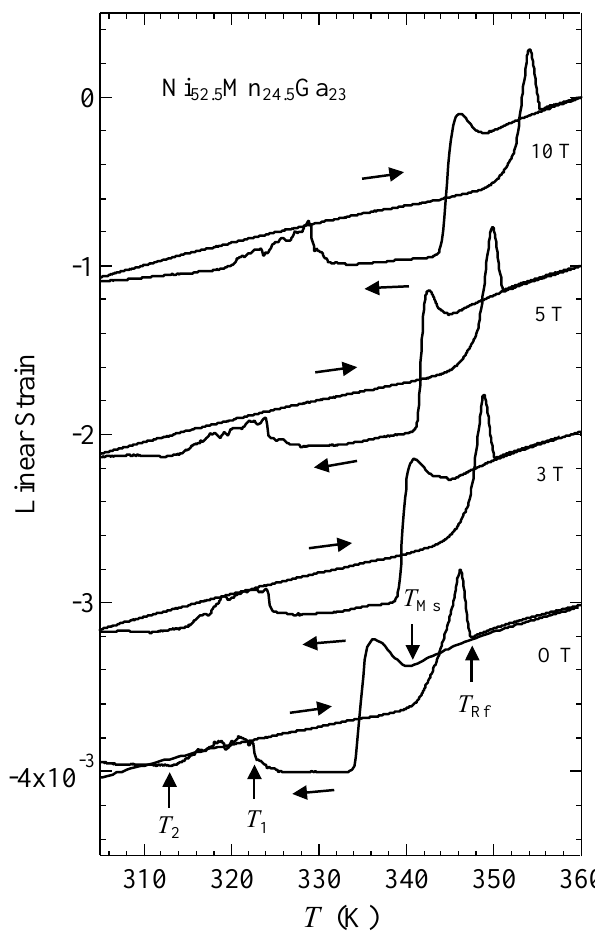
Figure 2. Temperature dependence of the linear thermal strain of Ni magnetic